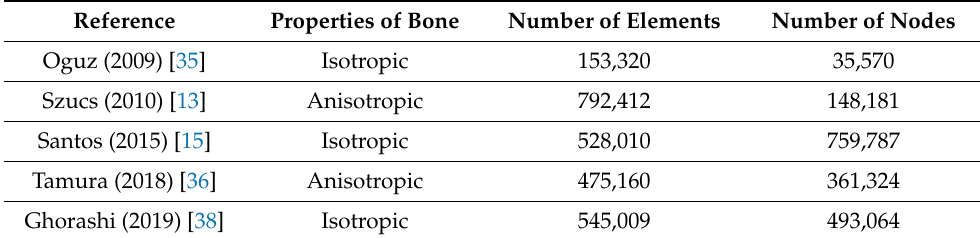
Table 6. Di ff erences between mandible models presented in FEA